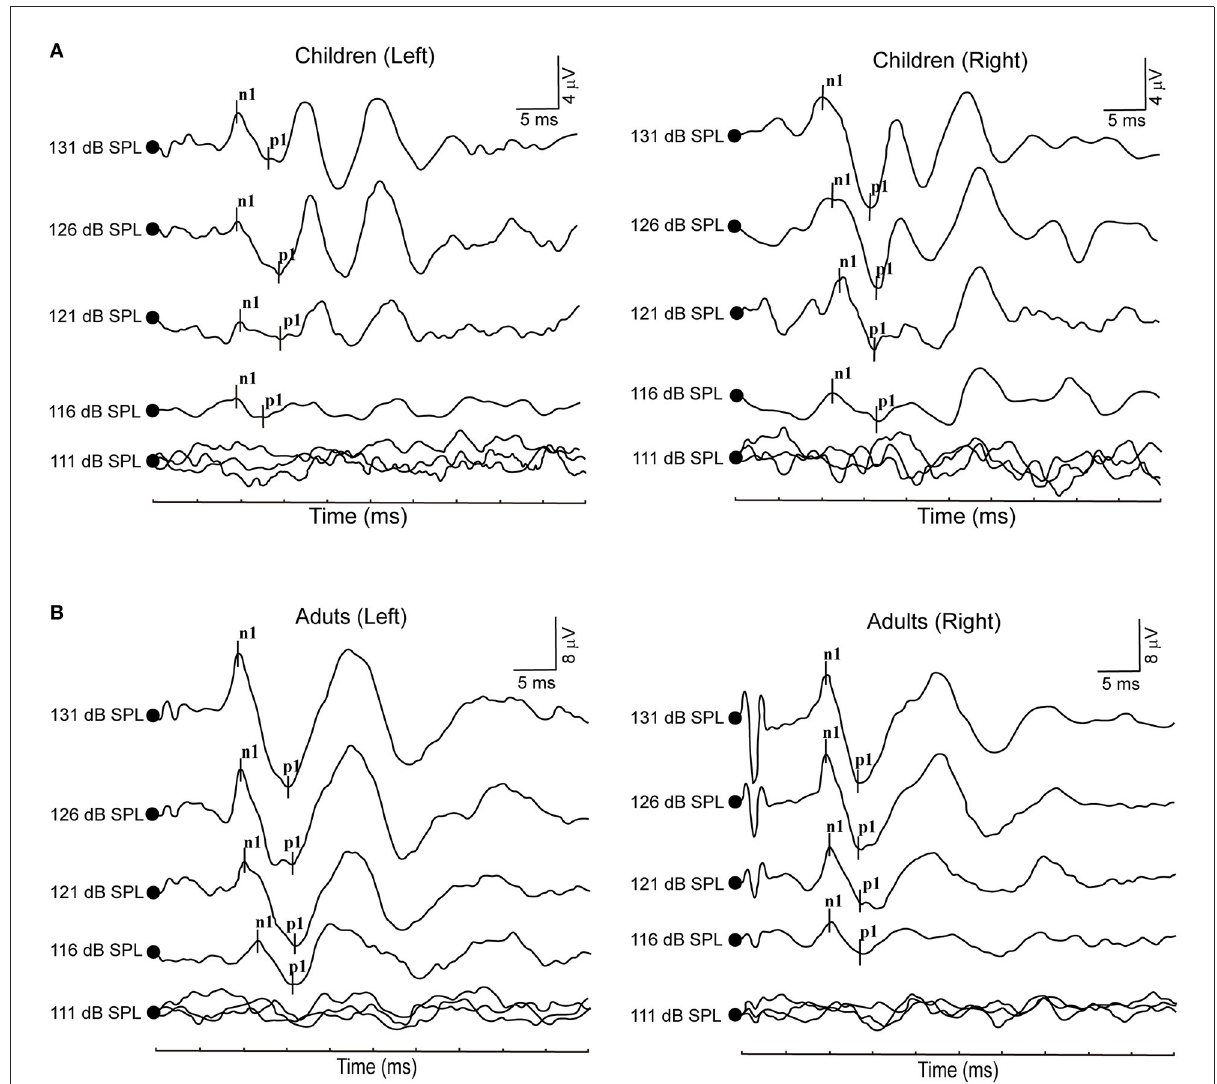
FIGURE1 (A) Clear oVEMP waveform in a child in response to ACS stimuli. (B) Clear oVEMP waveform in an adult in response to ACS